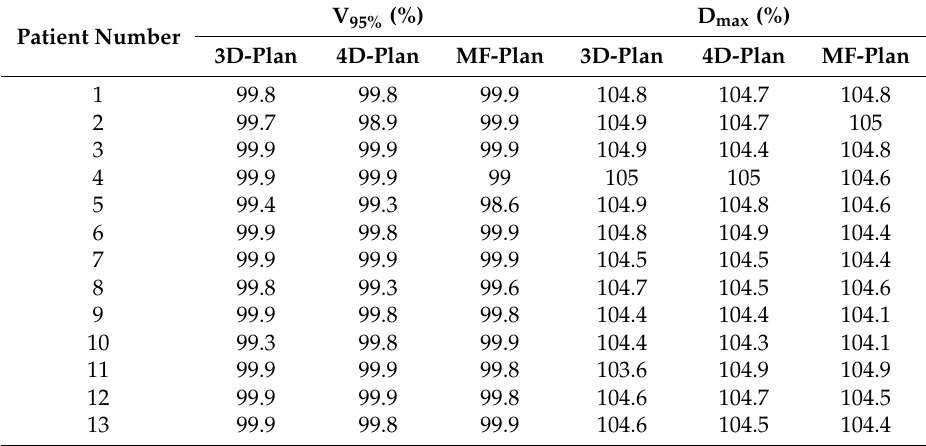
Table 7. Percentage volume that received at least 95% of the prescription dose (V 95% ) and the maximum target dose (D max ) of the patients under the different treatment plans for respiratory-gated radiation